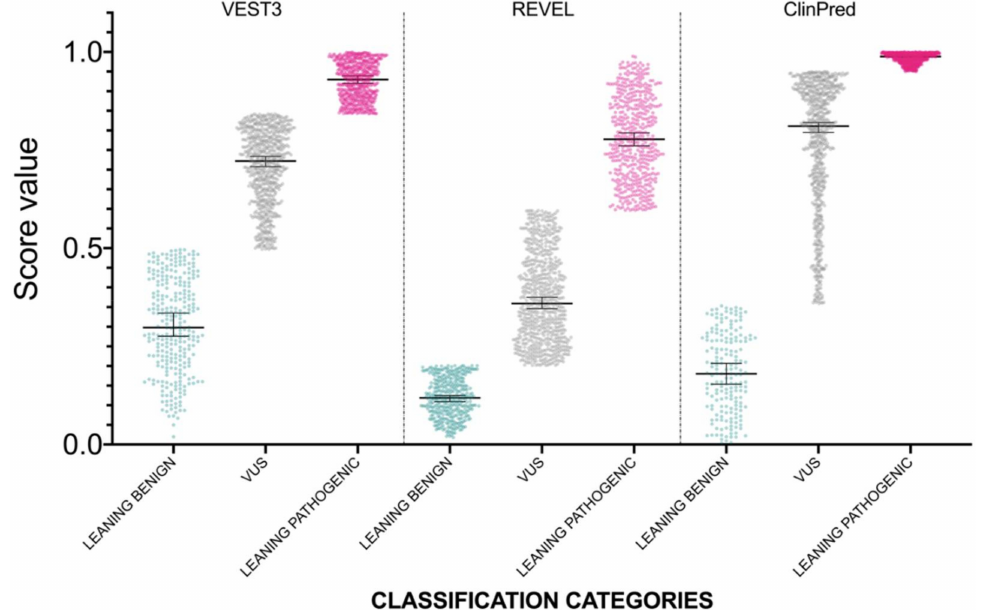
Figure 4. Prediction score values after reclassification of NF1 missense variants in the three categories LEANING BENIGN, VUS, and LEANING PATHOGENIC. For each category, median and 95% confidence intervals are